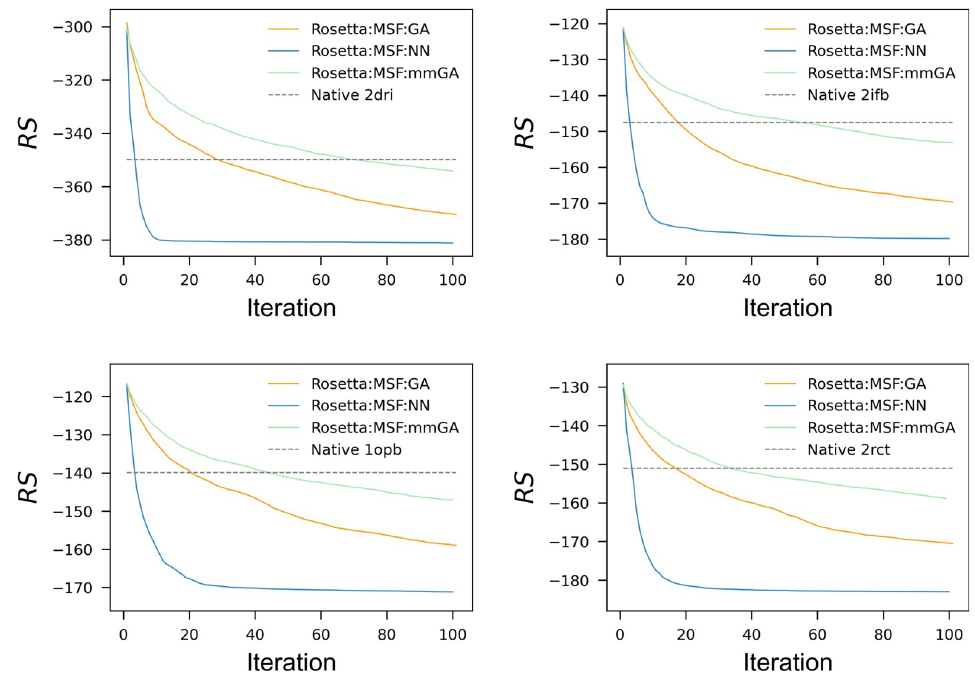
Fig 3. Convergence of Rosetta:MSF:GA:enzdes, Rosetta:MSF:mmGA:enzdes, and of Rosetta: MSF:NN :enzdes. The three protocols were utilized for each of the four designs from repr_prot . The mean Rosetta scores RS (OPT r ) were determined in REUs for each iteration r = 1–100 and plotted. The blue lines represent the RS NN (OPT r ) values, the orange lines the RS GA (OPT ) and the green line the RS mmGA (OPT ) values. The dashed horizontal line marks r r the score of the relaxed native protein; the PDB-ID of the corresponding native protein is indicated. The Rosetta: MSF:GA:enzdes and Rosetta:MSF:NN:enzdes plots for all 16 designs are shown in S3 Fig. mmGA is a genetic algorithm that introduces multiple